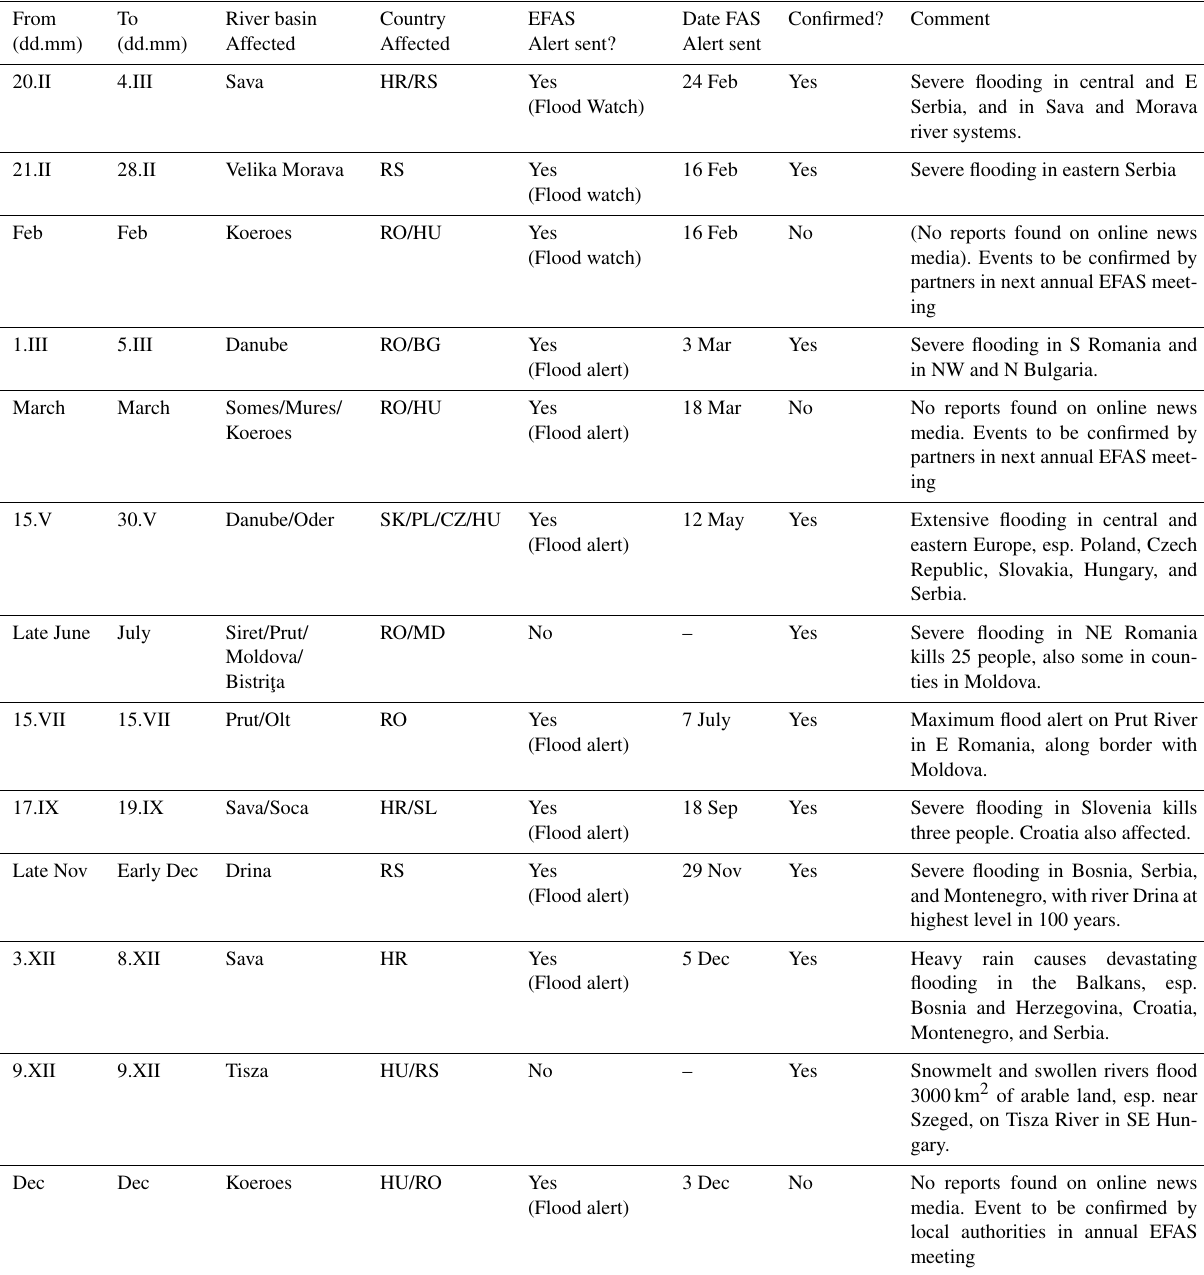
Table 1. Overview of main flood events for the Danube River basin in 2010, as forecasted by EFAS and/or reported in international online news media (ICPDR,